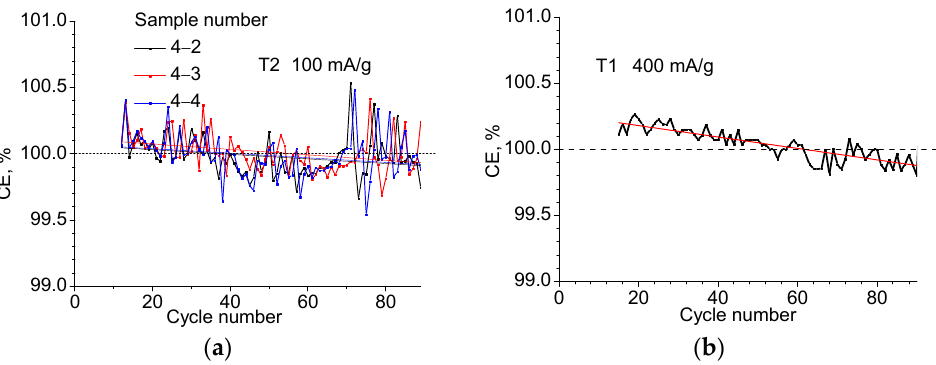
Figure 4. Coulombic efficiency of three T2 samples at current density j = 100 mA/g ( a ) and one T1 sample at j = 400 mA/g ( b ) as a function of cycle number.